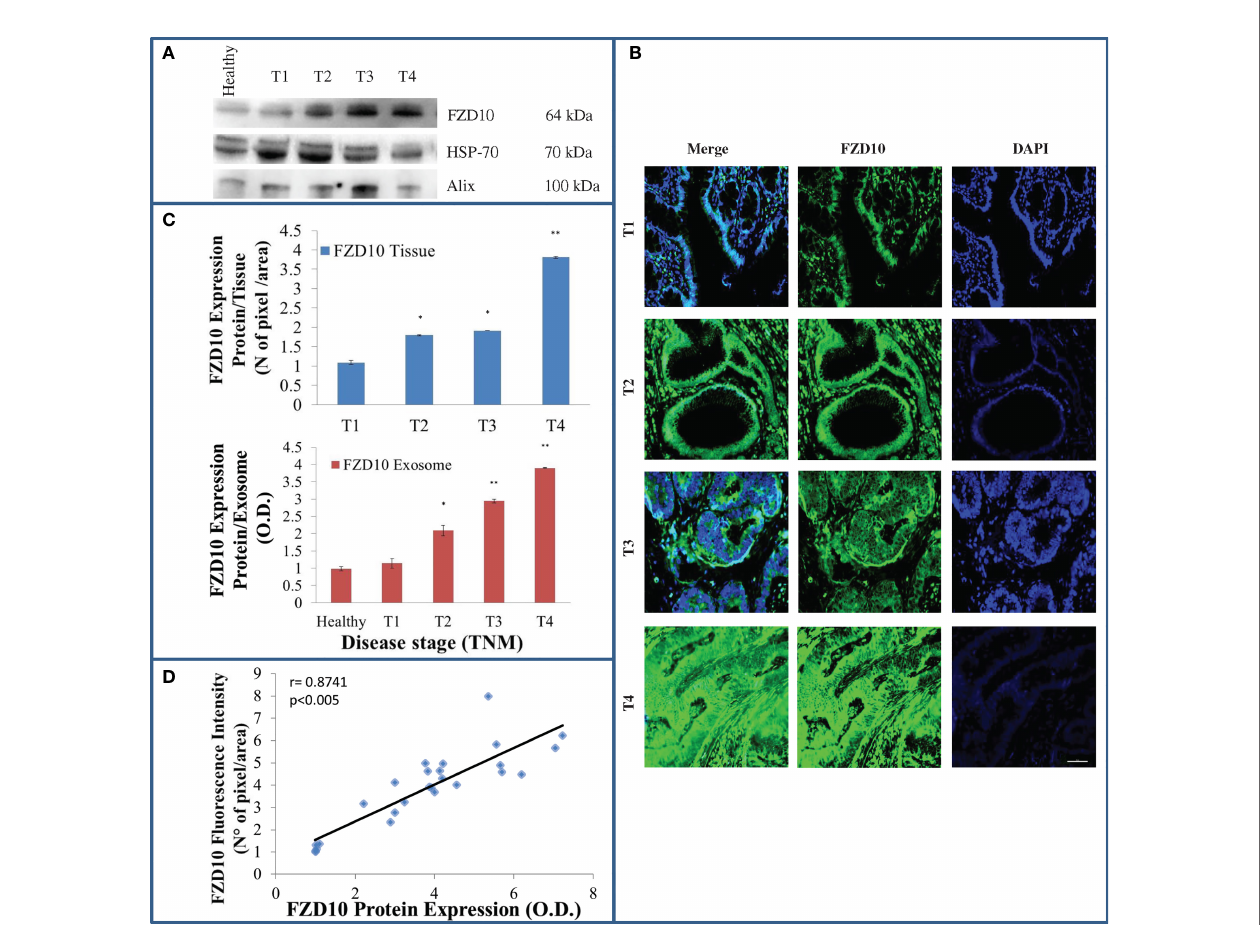
FIGURE 1 | Evaluation of Frizzled (FZD)10 in exosomes isolated from plasma and corresponding tissue samples derived from (26) colorectal cancer (CRC) patients at different TNM stages. Representative Western blotting of FZD10 and the two marker proteins (HSP-70 and ALIX) in exosomes derived from (20) healthy donors and CRC patients (A) . Representative confocal microscopy images of CRC tissues for the detection of FZD10 by immuno fl uorescence. Blue channel: nuclei; green channel: labeled FZD10 and corresponding overlay. Scale bar, 50 µm. Magni fi cation, ×20 (B) . Semiquantitative evaluation of FZD10 expression level in exosomes extracted from healthy donors and CRC patients by video-densitometry analysis of FZD10 bands on Western blotting. The HSP-70 protein band was used for the normalization of the FZD10 band for each subject. (*) p < 0.005 and (**) p < 0.001 vs . healthy donors (red bars). FZD10 expression levels, quantitatively evaluated as mean green fl uorescence intensity index, in tissues by immuno fl uorescence (blue bars). (*) p < 0.005 and (**) p < 0.001 vs . CRC patients with stage T1 (C) . Pearson ’ s correlation between FZD10 expression levels in exosomes determined by Western blotting analysis and in the corresponding tissues determined by immuno fl uorescence analysis for each CRC-affected subject from stages T1 to T4. p < 0.005 (D)